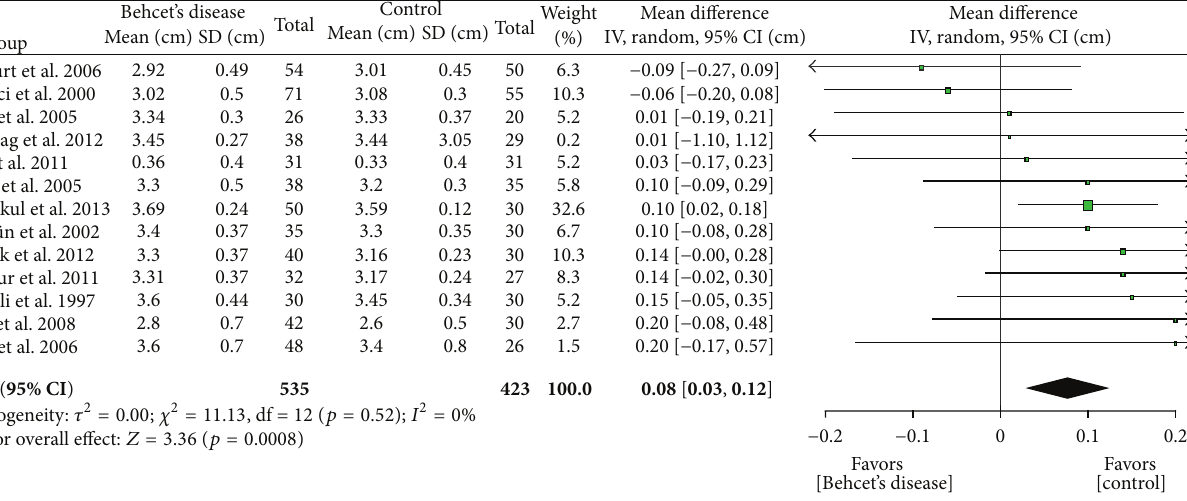
Figure 3: Left atrial dimension comparison between patients with Behcet’s disease and